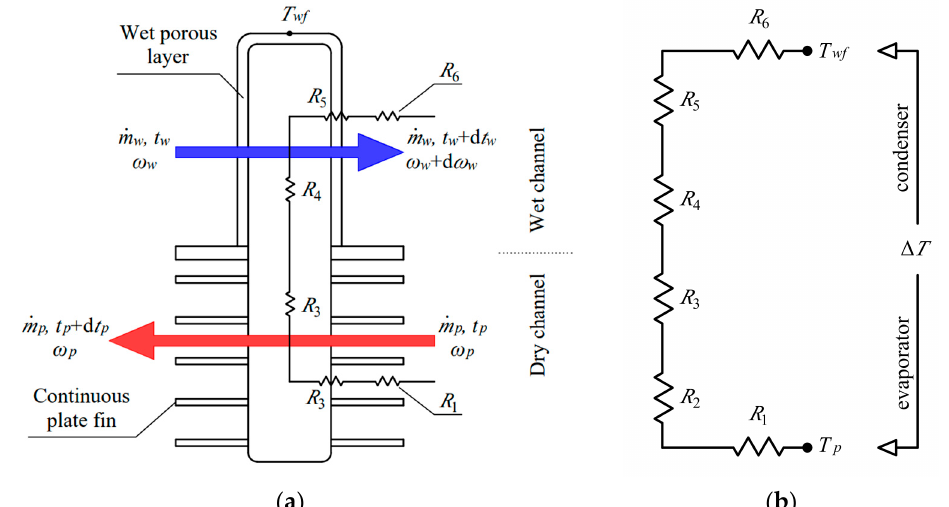
Figure 4. Schematic view: ( a ) computational element for mathematical modeling; ( b ) thermal resistance network for GAHP.